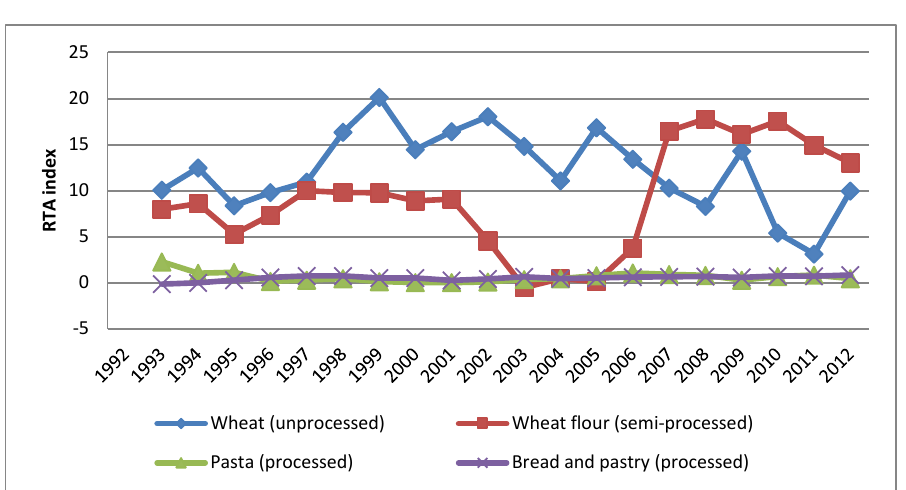
FIGURE A1: Trends in RTA index values for unprocessed, semi-processed, processed wheat in Argentina